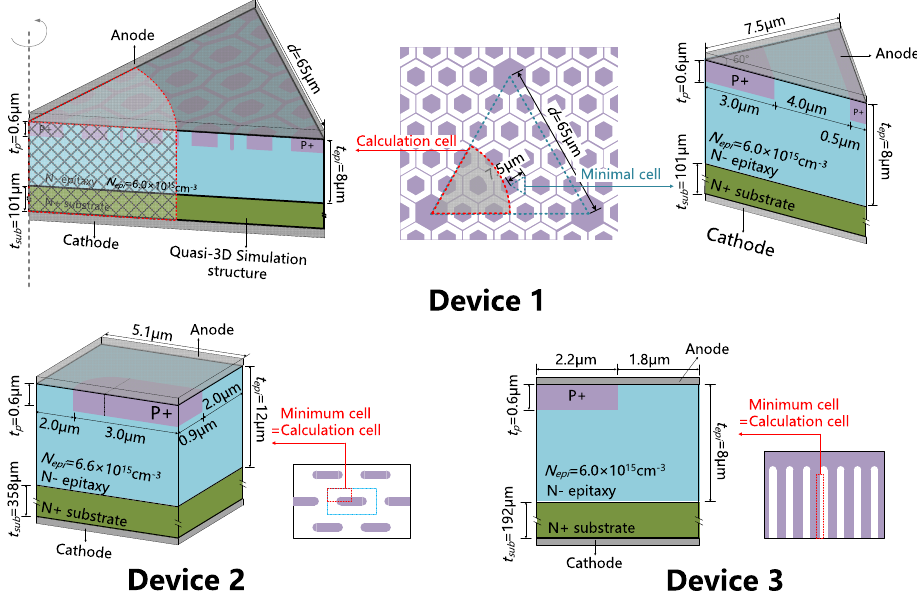
Figure 1. Layout designs of the three MPS diodes under test, drawn according to the microscopic observations. Colored regions stand for P+ regions in the active region. Device 1 has large P+ dots in its active region.